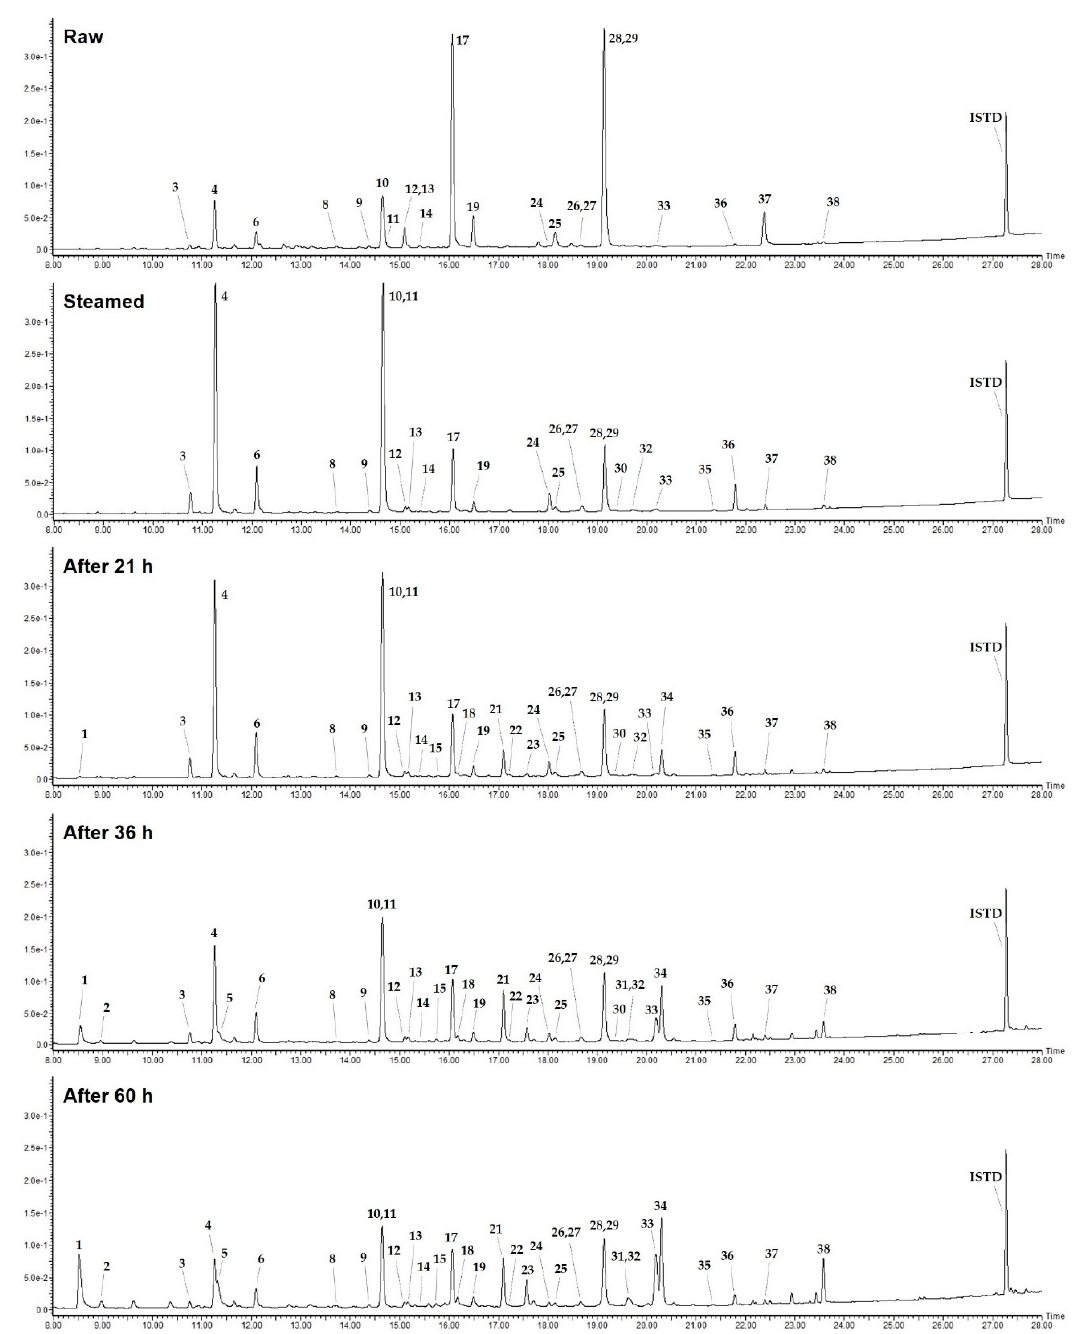
Figure 1. UPLD ‐ DAD chromatograms of 38 isoflavone derivatives (wavelength at 254 nm) from the raw, steamed and fermented (after 21, 36 and 60 h) seed samples of soybean cultivar, ‘KLS 87248’. After steaming, Ac ‐ Glu slightly contained in raw soybeans increased potentially as numerous isomers due to decarboxylation of Mal ‐ Glu [32]. Seven Ac ‐ Glu isomers ( m/z